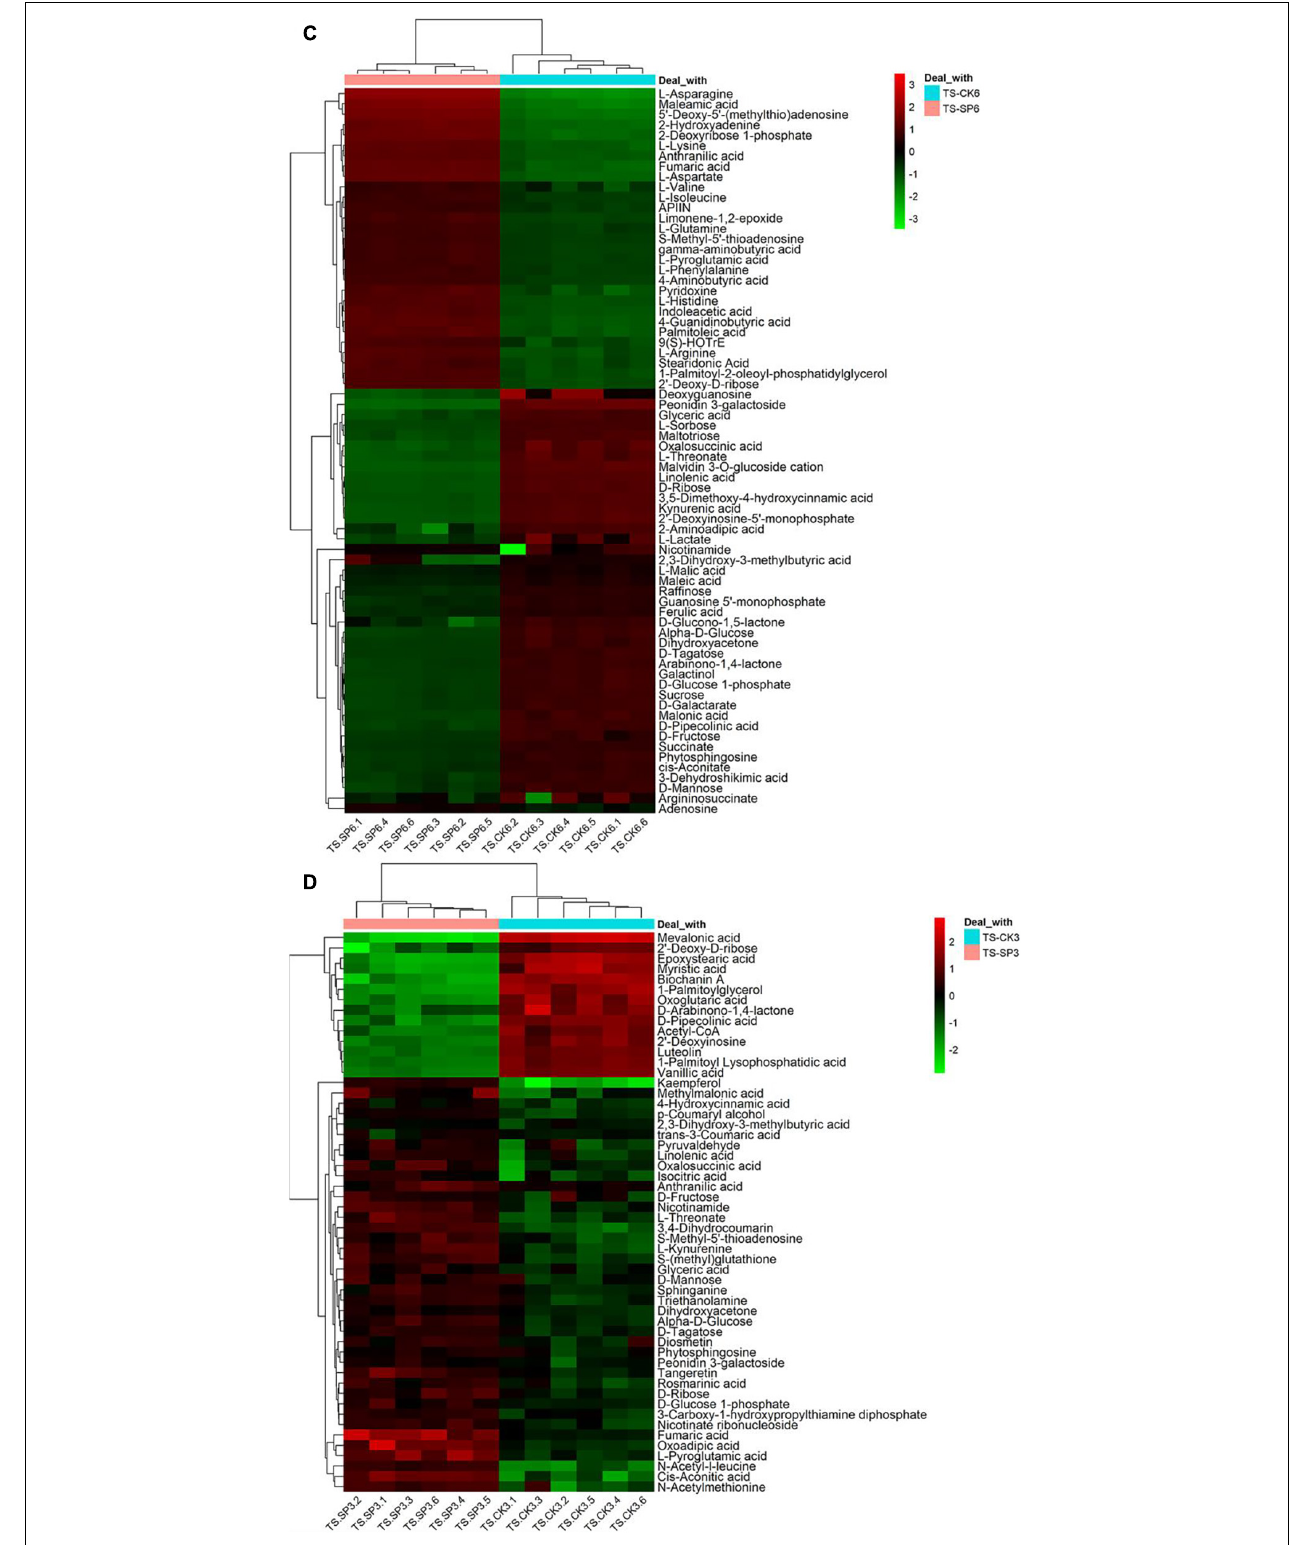
FIGURE 5 | Hierarchical cluster heat map of different metabolites under spaceflight stress of rice leaves; (A) Rice samples of DN3 at the TLP, (B) rice samples of DN6 at the TLP, (C) rice samples of DN3 at the TS, (D) rice samples of DN6 at the TS.